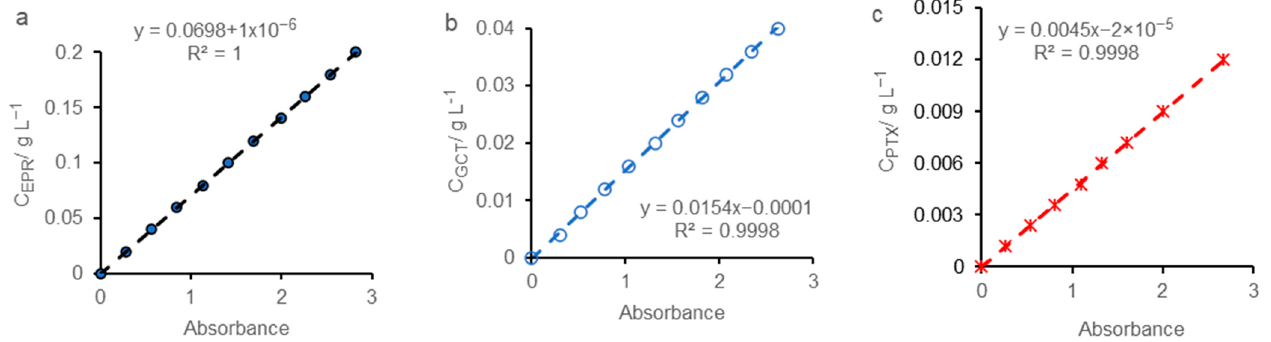
Figure 9. Calibration curve recorded for epirubicin ( a ), gemcitabine ( b ), and paclitaxel ( c ) in 5 × 10 − 2 mol L − 1 HCl solution.